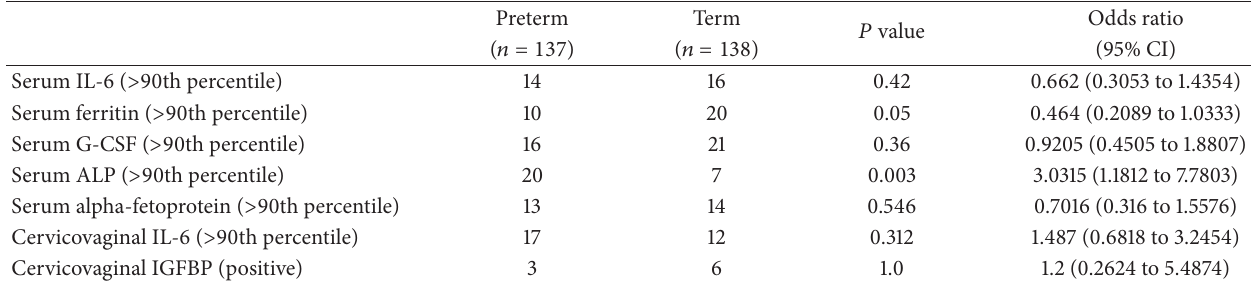
Table 3: Showing number of patients with more than 90th percentile of various predictive markers in both the